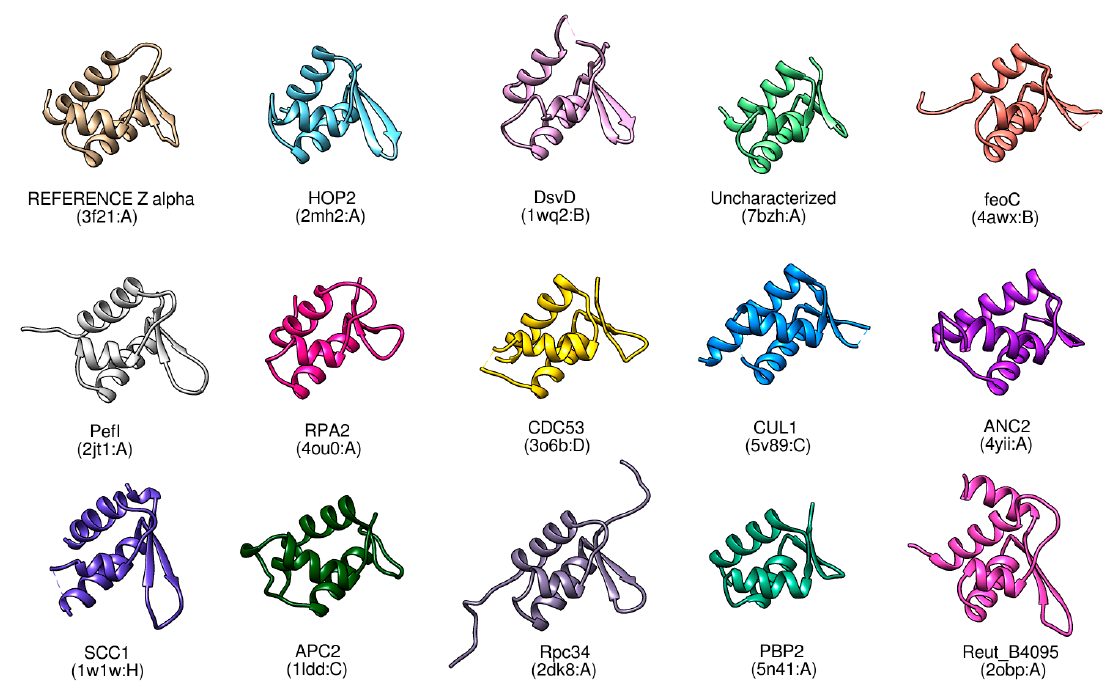
Figure 2. Comparison of the reference Z α domain (PDB: 3f21) (upper left corner) with the experimentally solved proteins (or their corresponding domains) having significant structural similarity (structures are ordered according to their similarity score to the reference structure (HOP2 best, DsvD second best, etc.).